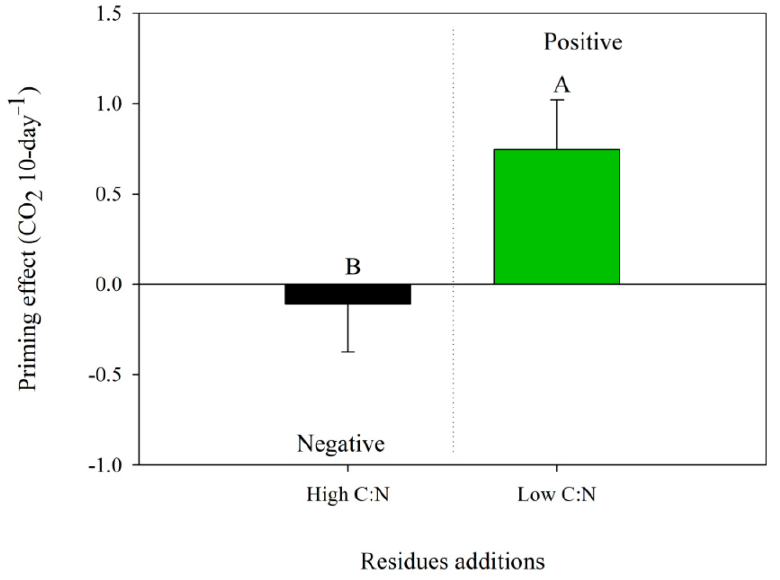
Figure 6. Priming effect (positive and negative) in soil with residue additions with high and low C:N. Means were compared by t test ( p < 0.05).